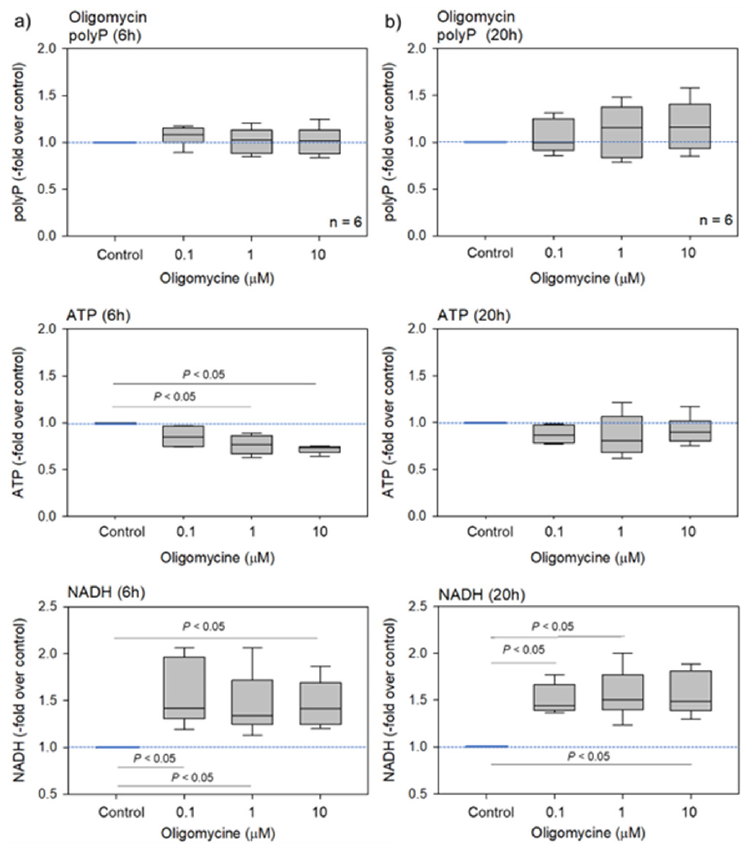
Figure 1. The effects of oligomycin on platelet polyP, ATP, and NADH levels after 6 h ( a ) or 20 h ( b ) of treatment. Statistical analysis was performed using a non-parametric test. n = 6.